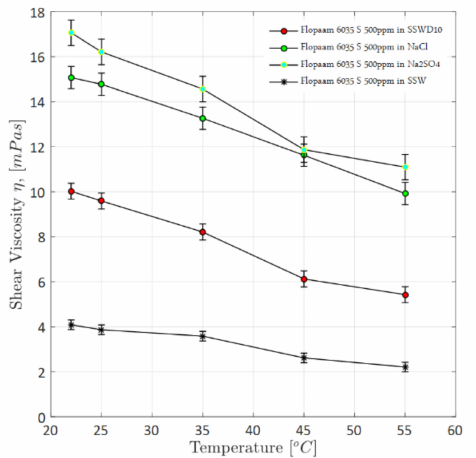
Figure 4. Comparison of steady-shear viscosity of polymer solutions at a temperature range of 22–55 ◦ C and shear rate of 10 s − 1 . The diluted solutions were prepared in four di ff erent brines, described